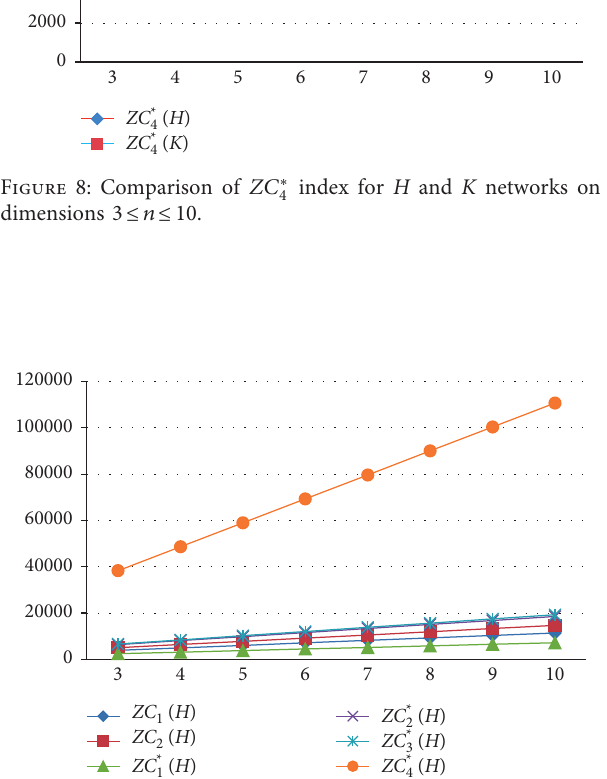
index for H and K networks on 2